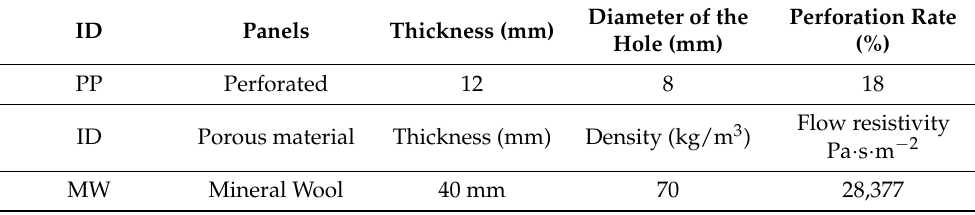
Table 1. Properties of perforated panel and porous